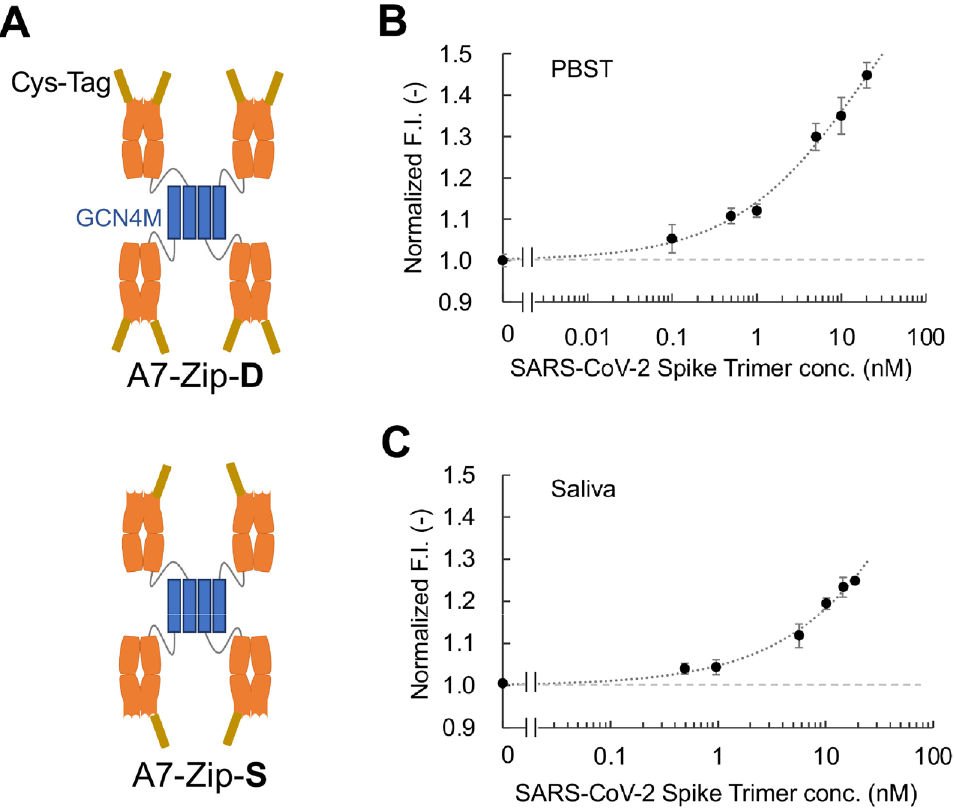
Figure 8. Oligomerized A7 Fab (A7-Zip) Q-body detects the SARS-CoV-2 spike protein at sub-nanomolar concentration. ( A ) Illustration of the two A7-Zip variants for Q-body conversion. A7-Zip-D: double dye- labeled on each Fab; A7-Zip-S: single dye-labeled on each Fab. The blue bar refers to the modified GCN4 oligomerization domain. ( B ) Dose–response curve for SARS-CoV-2 spike protein trimer spiked in PBST buffer with the A7-Zip-S-TAMRA Q-body. n = 4; ( C ) Dose–response curve for SARS-CoV-2 spike protein trimer spiked in human saliva sample with the A7-Zip-S-TAMRA Q-body. n = 3; Data have been expressed as mean ± standard